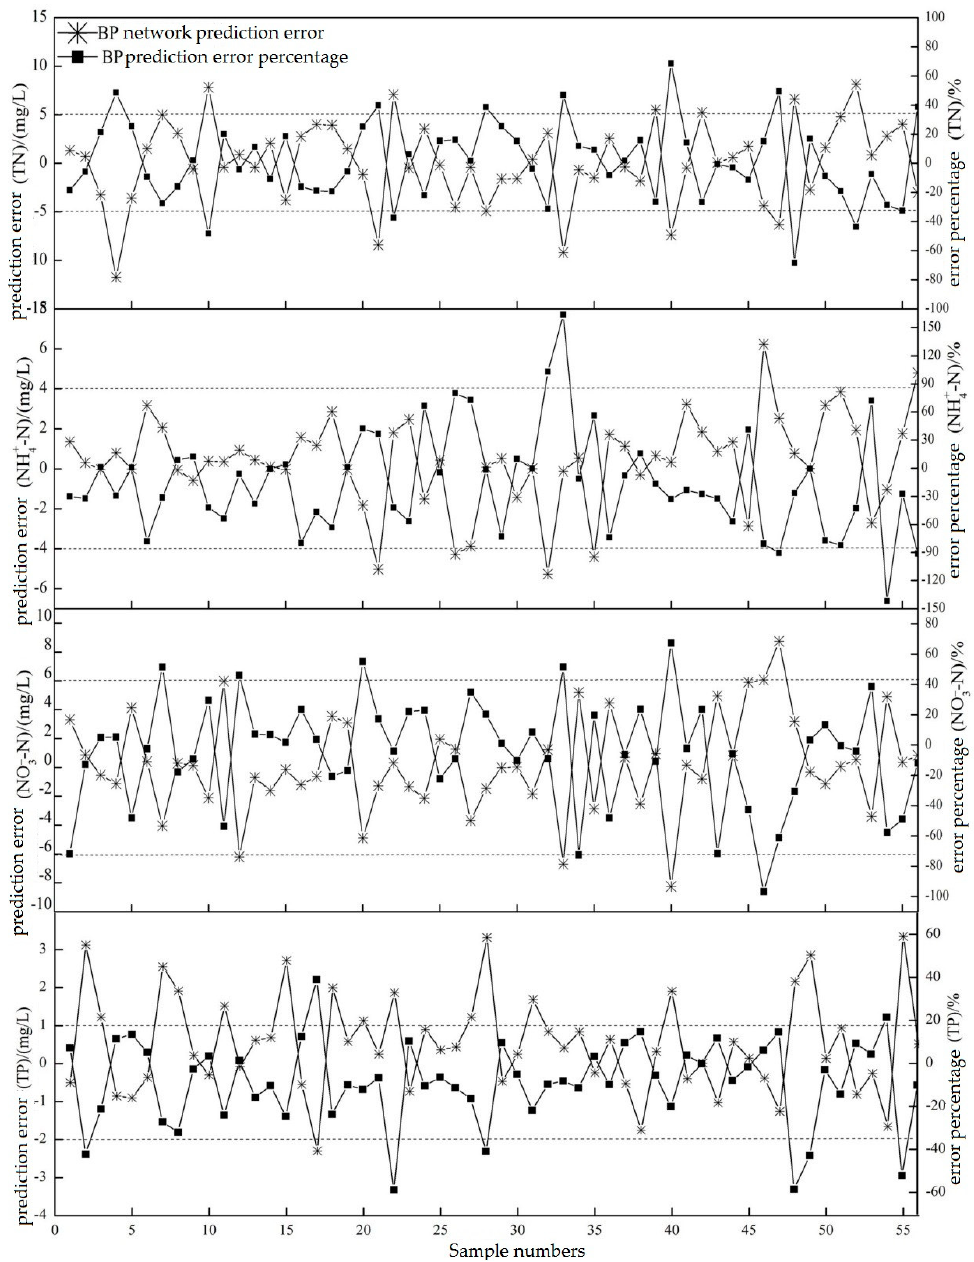
Figure 10. Prediction error and the percentage prediction error of the BP network.